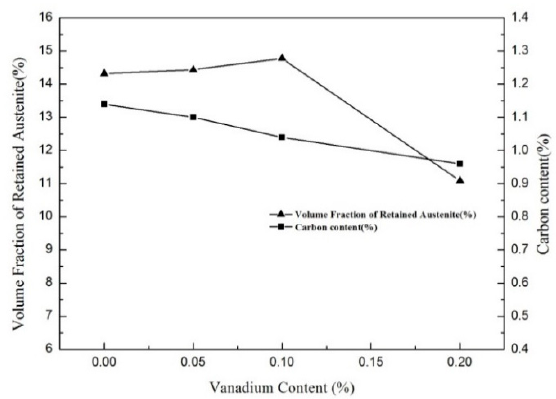
Figure 10. Volume fraction of retained austenite and carbon content in retained austenite with different vanadium contents.